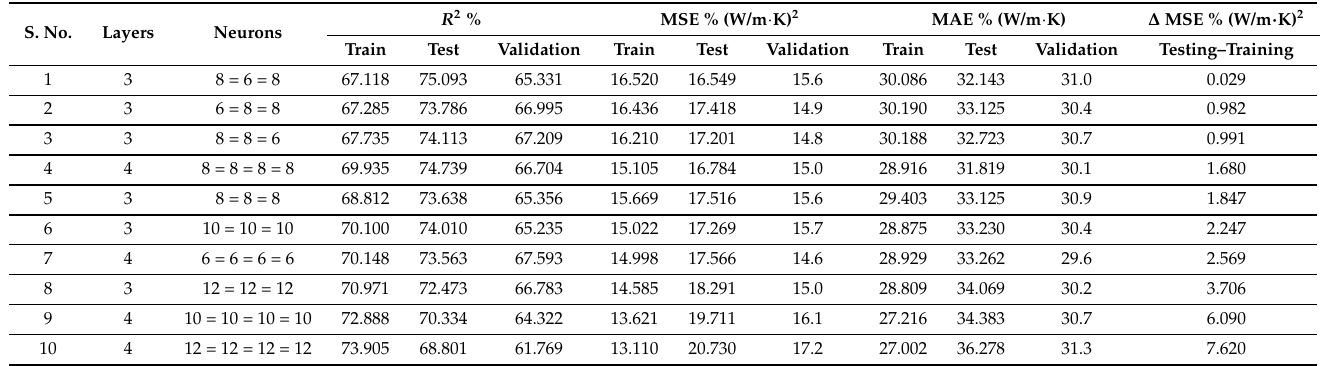
Table 1. Training, testing and validation results considering Network - I . Epochs = 800 and batch size =